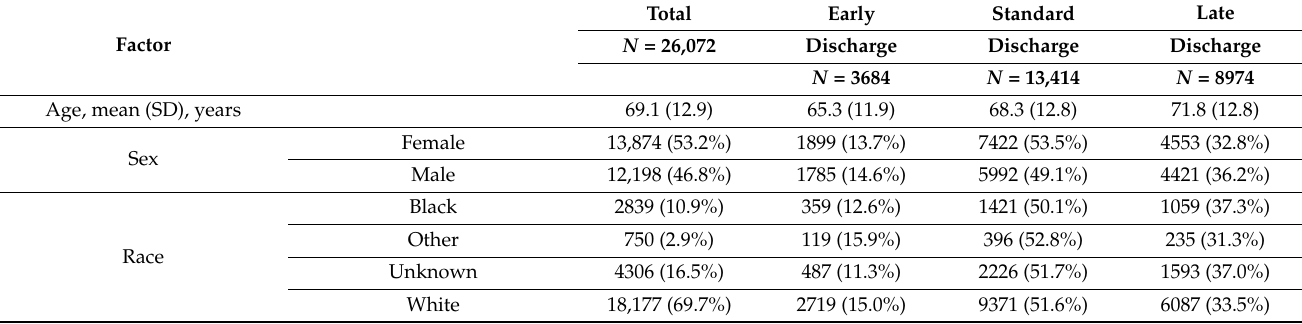
Table 1. Clinical and demographic factors of patients undergoing non-emergent right colectomy for colon cancer from 2012 to 2019, stratified by postoperative length of